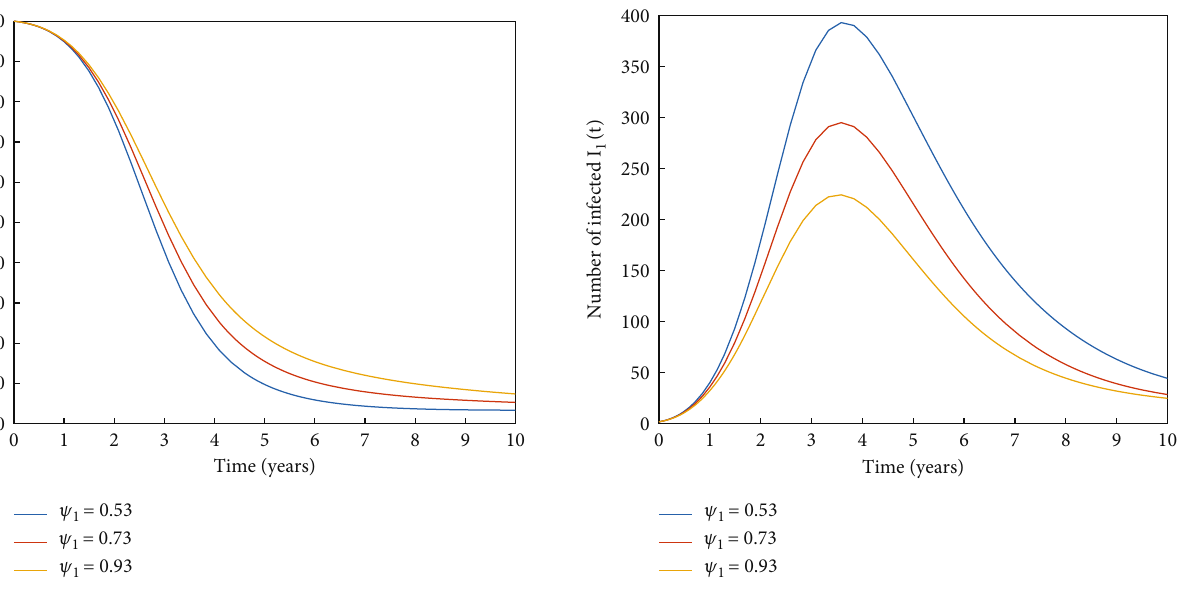
Figure 21: Transformation of infected individuals for recovery rate ψ 1 with various